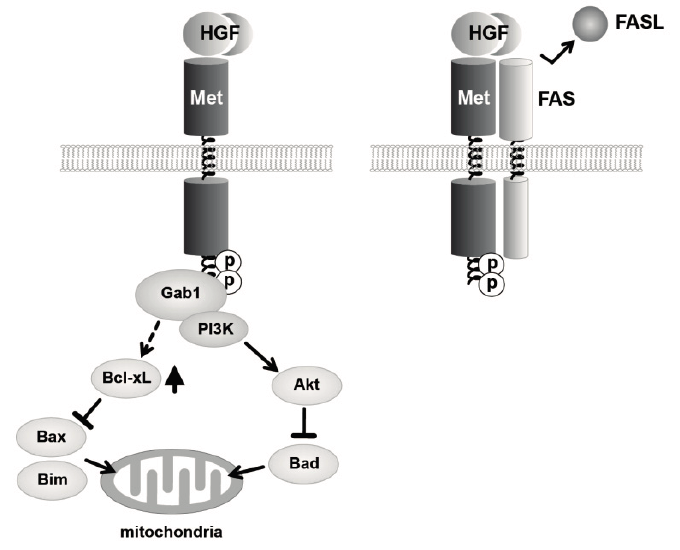
Figure 2. Signaling mechanisms responsible for promotion of cell survival mediated by HGF–Met